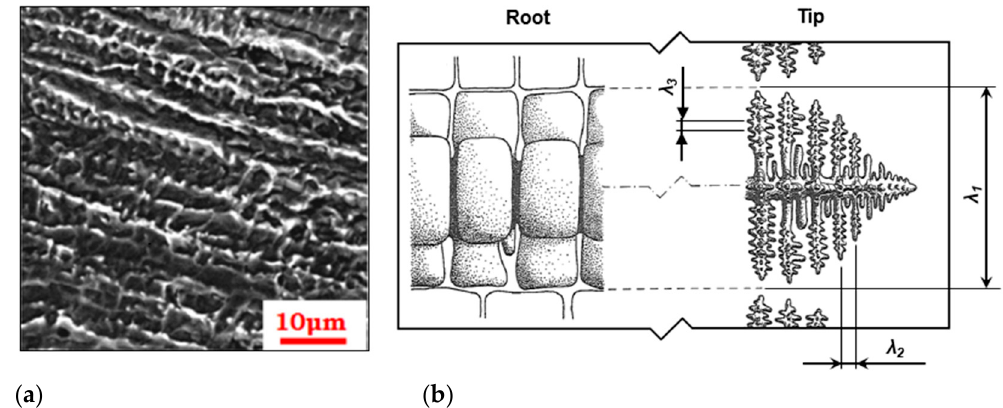
Figure 8. ( a ) SEM of cellular (columnar) dendritic structure in the WM of 304 SS [43] and ( b ) classification of dendritic arc spacing (modified from [49]). λ 1 , λ 2 , and λ 3 indicate primary, secondary, and tertiary dendrite arm spacing, respectively.